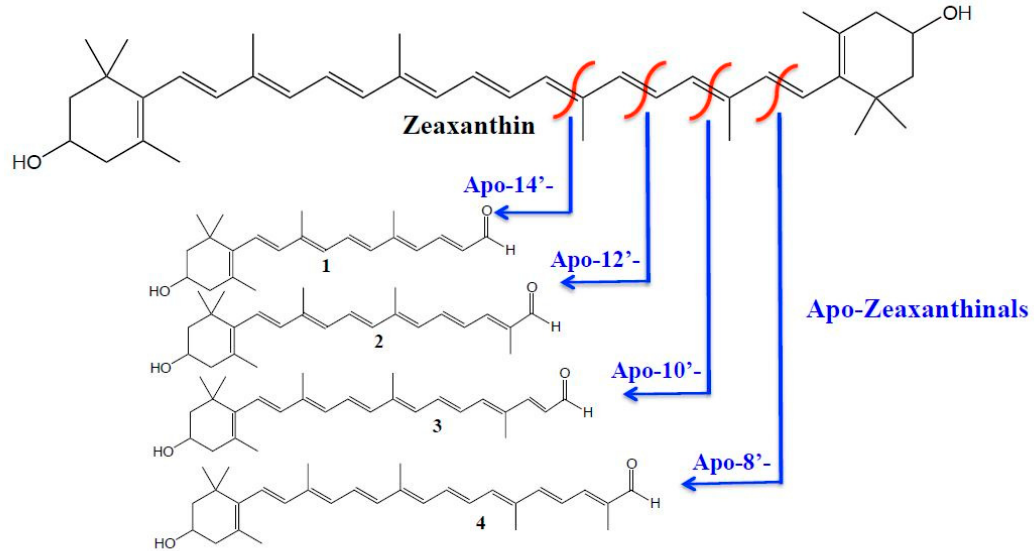
Figure 1. Zeaxanthin oxidative cleavages sites producing various apozeaxanthinals; 1 . Apo-14’- Zeaxanthinal; 2 . Apo-12’-Zeaxanthinal; 3 . Apo-10’-Zeaxanthinal; 4 . Apo-8’-Zeaxanthinal. Reprint with permission from